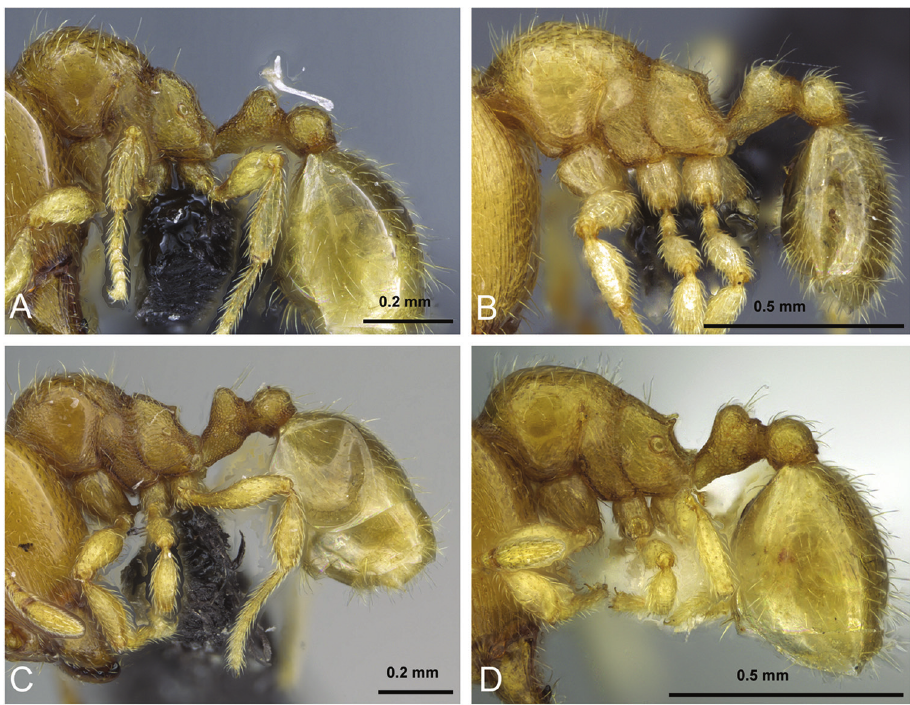
Figure 5. Body in profile view of A Carebara malagasy (CASENT0042186) B Carebara placida